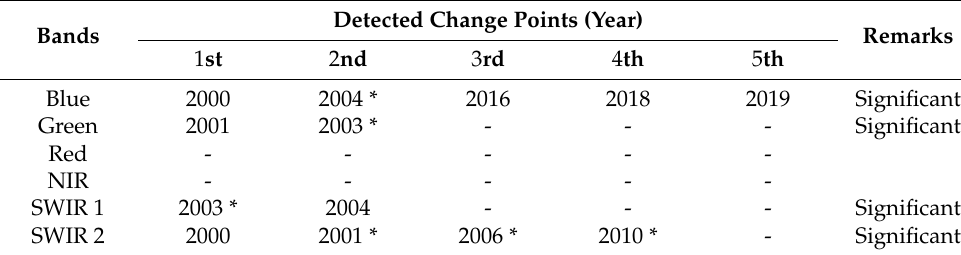
Figure 10. TOA reflectance data of the virtual constellation over Niger 1 for blue, green, red, NIR, SWIR 1, and SWIR 2 bands with fitted trend lines before and after turning points. Table 11. Change point detection by sequential versions of the Mann–Kendall test for Niger